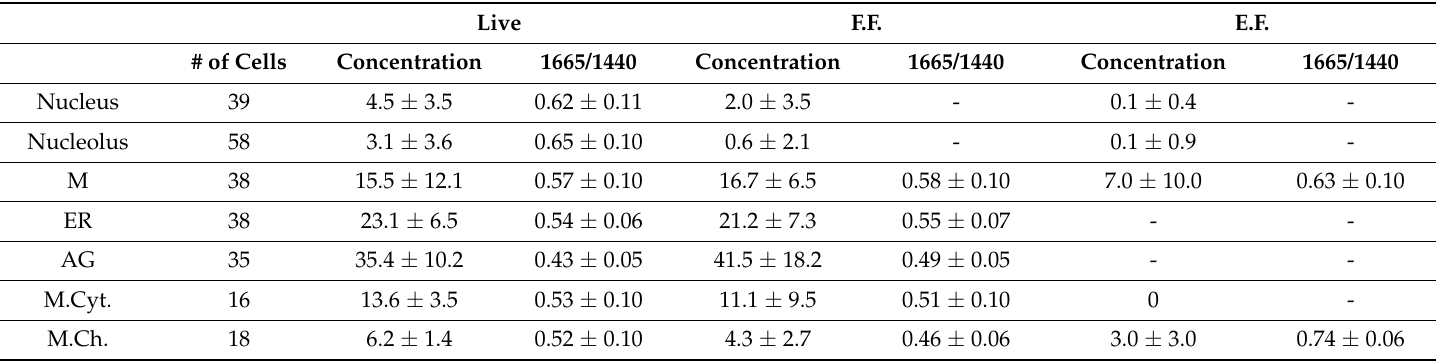
Table 2. Concentrations of lipids in different cellular organelles (M—mitochondrion, ER—endoplasmic reticulum, AG—apparatus Golgi, M.Cyt.—mitotic cytoplasm, M.Ch.—mitotic chromosome; F.F.—formaldehyde fixation, E.F.—ethanol fixation). Units: mg/mL. Live F.F.